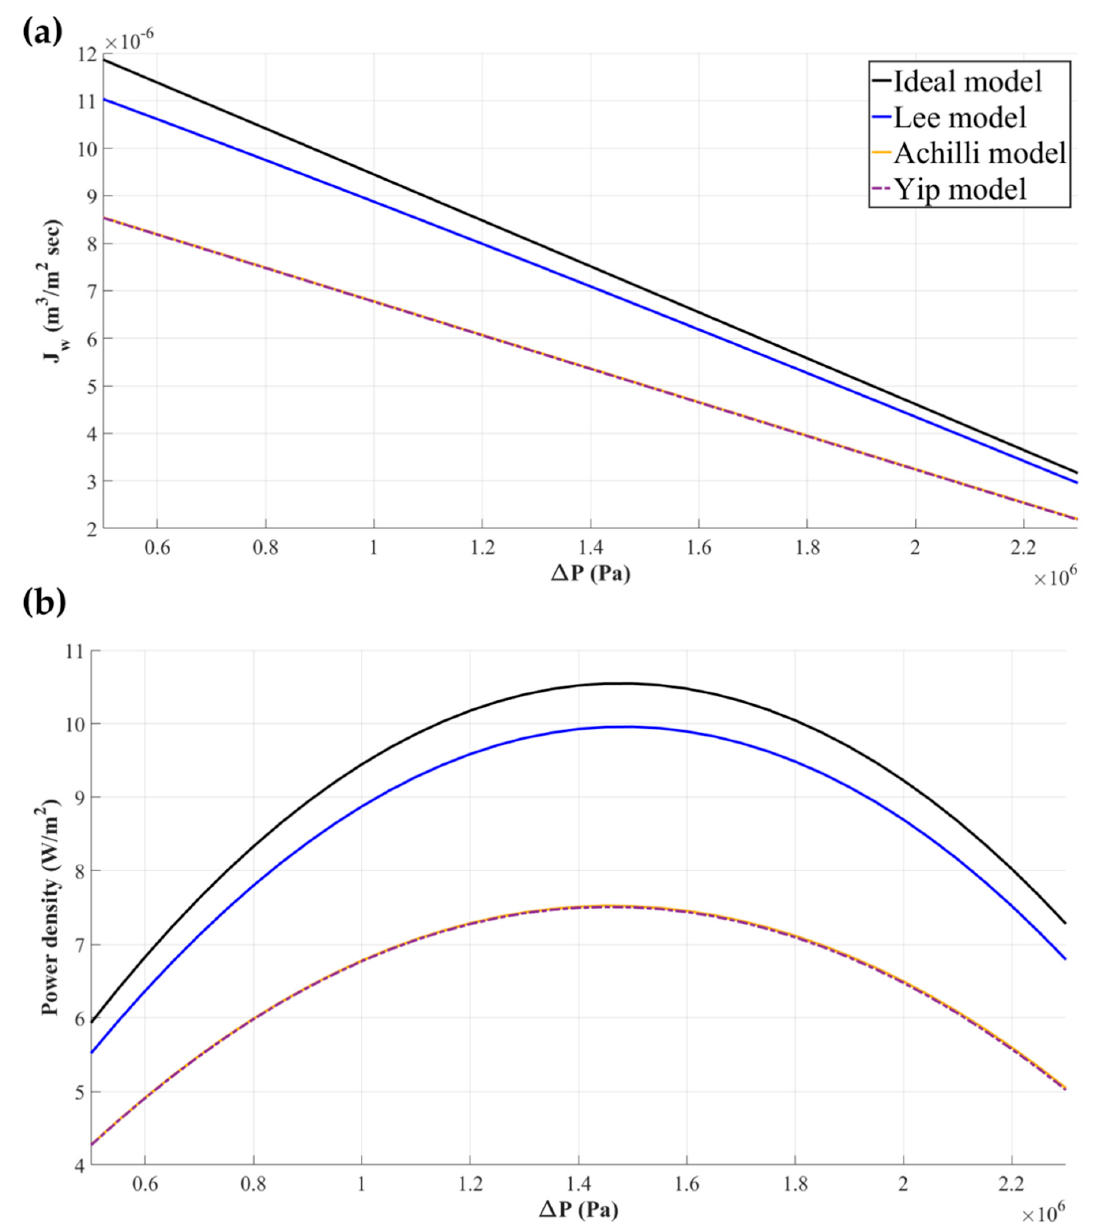
Figure 5. The variation of the water flux ( 𝐽 (cid:3050) ) and power density according to the external hydraulic pressure ( 𝛥𝑃 ). As seen in ( a ), the water flux in a PRO process gradually decreases as the types of concentration polarization are taken into consideration. Consequently, the magnitudes of power density naturally decrease, as shown in ( b ). In these figures, 𝐴 = 4.83 × 10 (cid:2879)(cid:2869)(cid:2870) m/s/Pa ; 𝐵 = 4.44 × 10 (cid:2879)(cid:2876) m/s ; 𝑆 = 3.07 × 10 (cid:2879)(cid:2872) m ; 𝐶 (cid:3005),(cid:3029) = 35,000 ppm ; 𝐶 (cid:3007),(cid:3029) = 1000 ppm ; 𝑘 = 3.85 × 10 (cid:2879)(cid:2873) m/s ; and 𝐾 = 2.06 × 10 (cid:2873) m (cid:2879)(cid:2869)